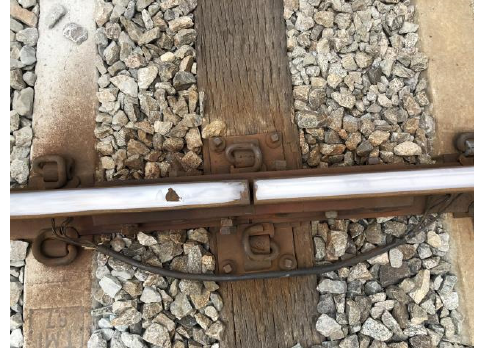
Figure 7. Rail joint section.